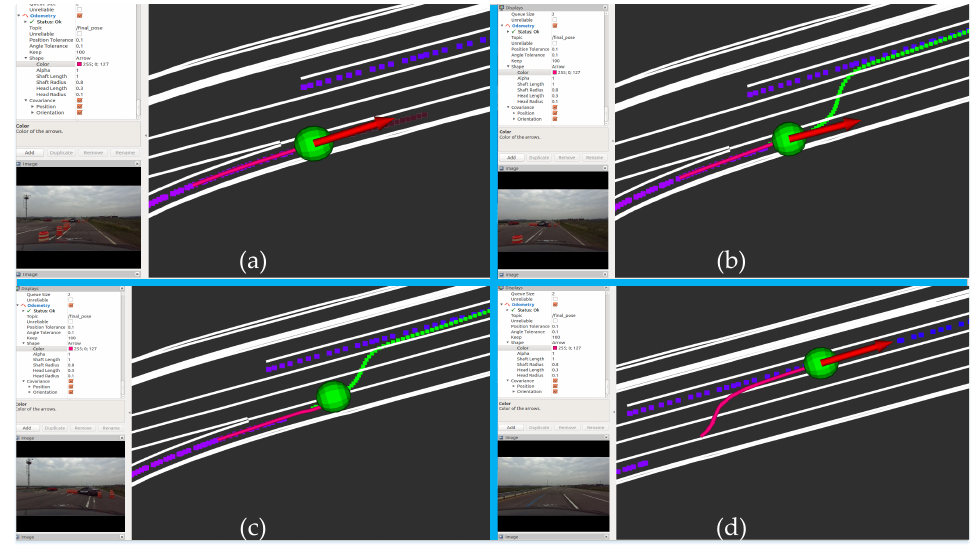
Figure 18. The local path with hybrid A* integrated into Rviz, ( a ) begins finding a route, ( b ) found a route, ( c ) following the route, ( d ) finish A*